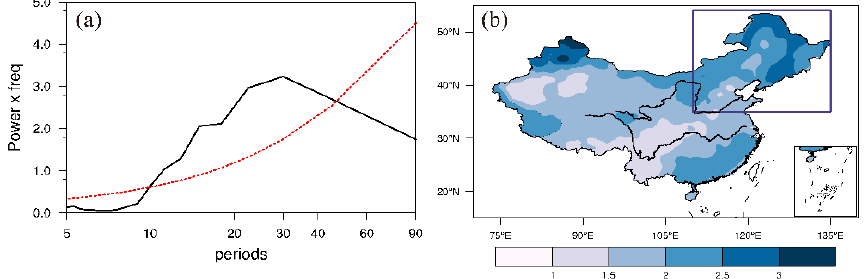
Figure 2. ( a ) Winter mean power spectra of daily T min over the NE-N region (solid black line) during 1979–2018. The dashed red line represents the 95% significant level of red noise spectrum. ( b ) Standard deviation of 10–30 d filtered T min (unit: ◦ C) in winter. The box denotes the NE-N region (35–55 ◦ N, 110–135 ◦